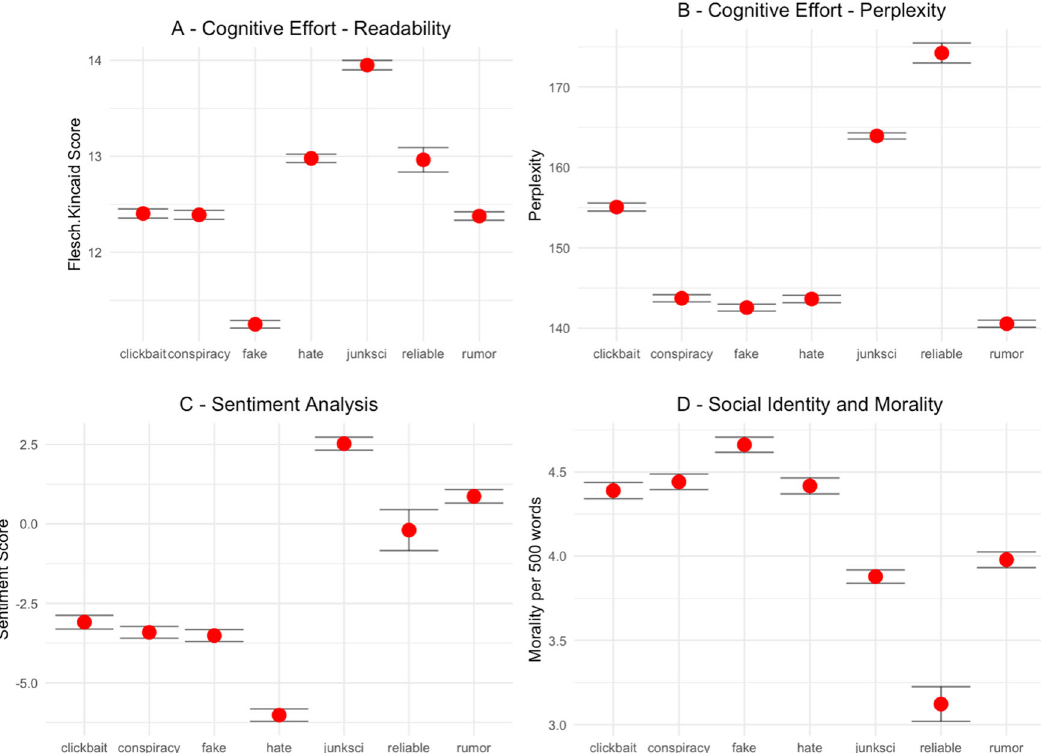
Fig. 1 The fi ngerprints of misinformation. A shows the cognitive effort needed to process a text using the Flesch-Kincaid readability score; B the cognitive effort as measured by perplexity; C plots the sentiment (positive, neutral, negative) of each category; D shows the appeal to morality in each category.